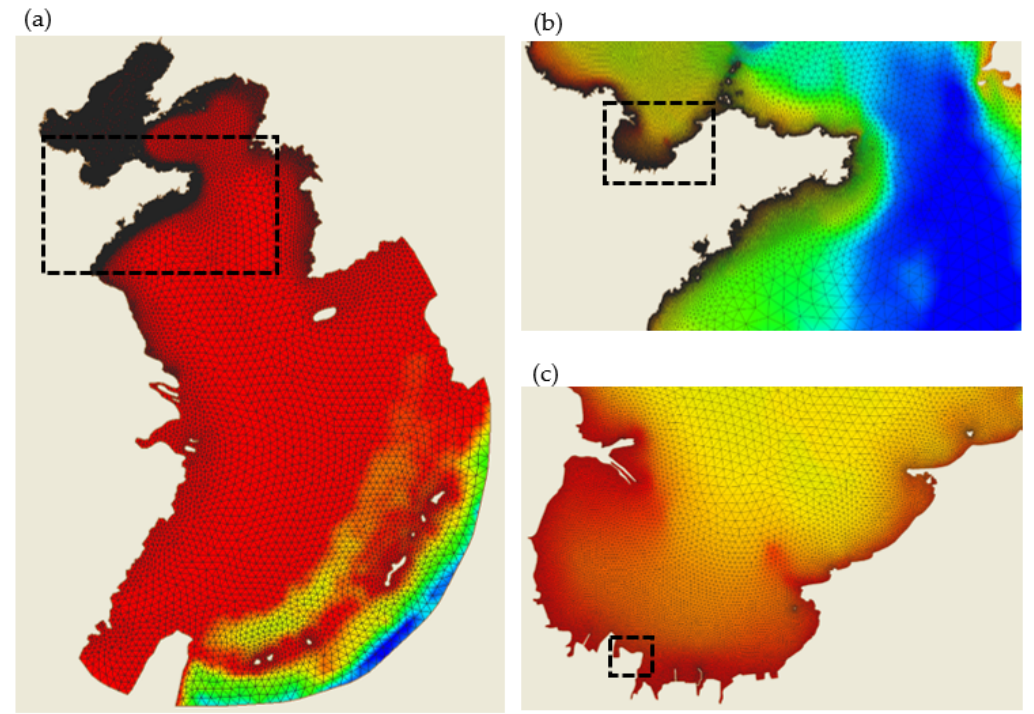
Figure 3. Computational grids of ( a ) the entire study domain, ( b ) Shandong offshore area, and ( c ) Laizhou Bay.